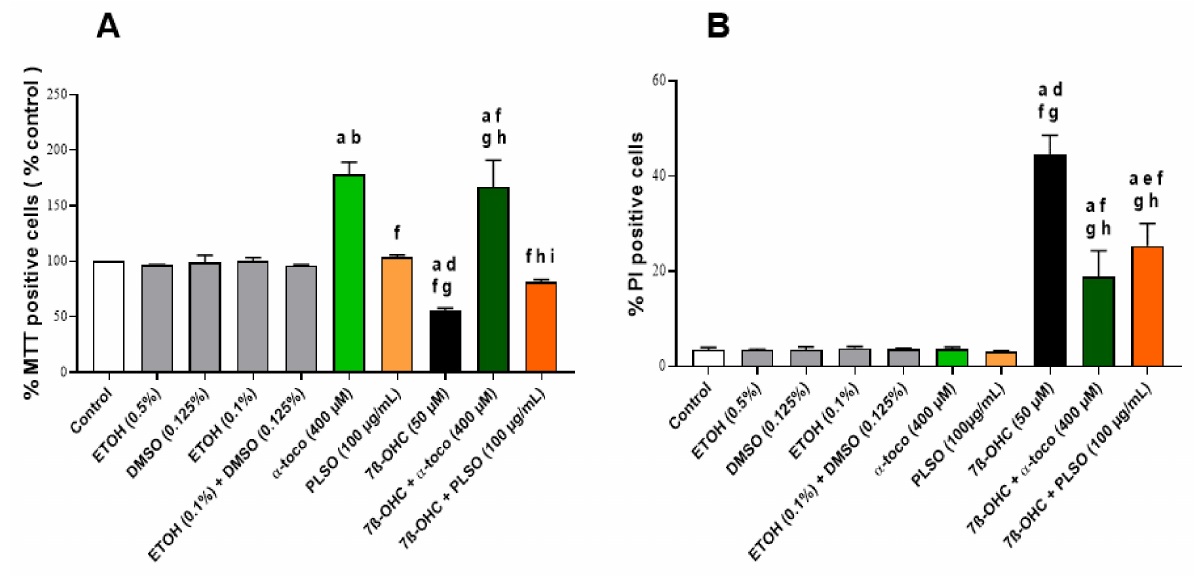
Figure 1. Effect of Pistacia lentiscus L. seed oil ( PLSO ) and 7 β -hydroxycholesterolin C2C12 cell viability. C2C12 cells were incubated for 24 h with or without 7 β -OHC (50 µ M) in the presence or absence of PLSO (100 µ g/mL) or α -tocopherol (400 µ M). The protective effect of PLSO and α -tocopherol against 7 β -OHC-induced cell death was evaluated with the MTT assay ( A ) and by flow cytometry after staining with propidium iodide (PI) ( B ). Data are the mean ± SD of two independent experiments performed in triplicate. A multiple comparative analysis between the groups, tak- ing into account the interactions, was carried out using an ANOVA test followed by a Tukey’s test. A p -value less than 0.05 was considered statistically significant. The statistically significant differences between the groups, which are indicated by different letters, take into account the vehicle used. a: comparison versus control; b: comparison versus ETOH (0.5%); c: comparison versus DMSO (0.125%); d: comparison versus ETOH (0.1%); e: comparison versus (ETOH (0.1%) + DMSO (0.125%)); f: comparison versus α -toco (400 µ M); g: comparison versus PLSO (100 µ g/mL); h: com- parison versus 7 β -OHC (50 µ M); i: comparison versus 7 β -OHC (50 µ M) + α -toco (400 µ M). No significant differences were observed between the untreated (control) and vehicle-treated cells: EtOH (0.5%), DMSO (0.125%), EtOH (0.1%), and EtOH (0.1%) +DMSO